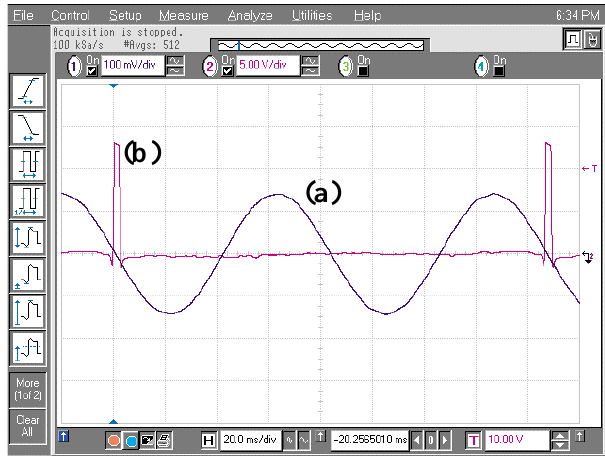
FIG. 6. (Color) Scope signals from rotating coil. (a) PC quad- rupole (100 mV (cid:1) div) and (b) synchronous signal (5.00 V (cid:1) div) from photogate circuit. The horizontal scale is 20 ms (cid:1)